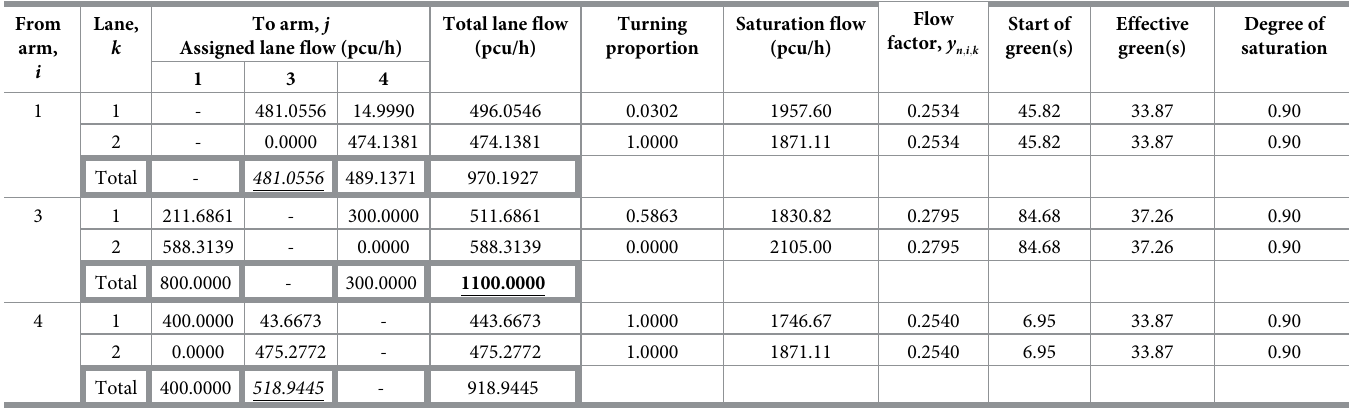
= z ¼ W = z ¼ 32 : 9 s (maximized), and z ¼ 1 = 120 : 0 . o ¼ 2 ; d ¼ 4 ; h o ; d ¼ 1 o ¼ 4 ; d ¼ 2 ; h o ; d ¼ 1